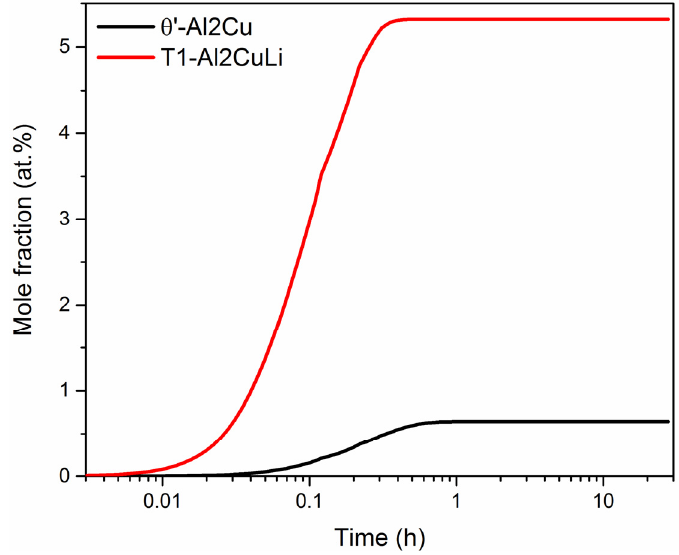
Figure 15. The kinetic curves of 2A97 alloy at 200 °C.